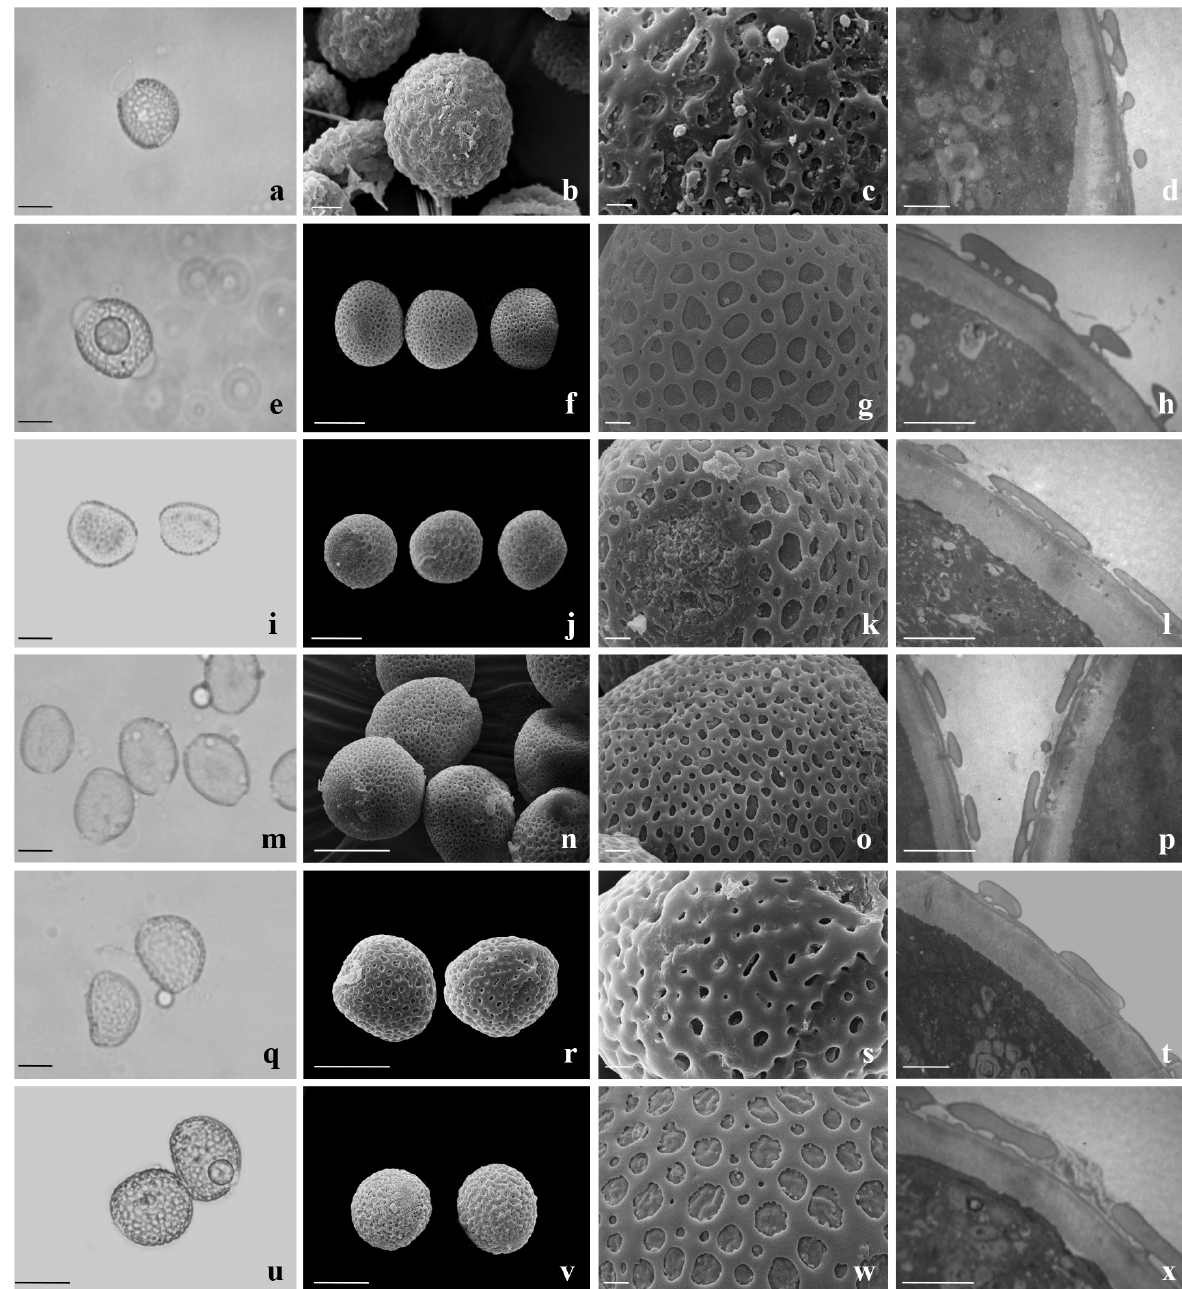
Figure 2 - Morphology and exine characteristics of pollen grains of Ananas and Pseudananas species . a-d ) Ananas sp.; e-h ) An. ananassoides ; i-l ) An. bracteatus ; m-p ) An. lucidus ; q-t ) An. parguazensis ; u-x ) P. sagenarius ; a, e, i, m, q, u ) pollen after lactic acetolysis; b, f, j, n, r, v ) polar and equatorial view; c, g, k, o, s, w ) detail of the ornamentation of the exine; d, h, l, p, t, x ) detail of grain wall; a, e, i, m, q, u ) images obtained by light microscopy, lactic acetolysis; b, c, f, g, j, k, n, o, r, s, v, w ) scanning electron microscopy; d, h, l, p, t, x ) transmission electronic microscopy. Bars: a, b, e, f, i, j, m, n, q, r, u, v = 20 µm; c, d, g, h, k, l, o, p, s, t, w, x = 2